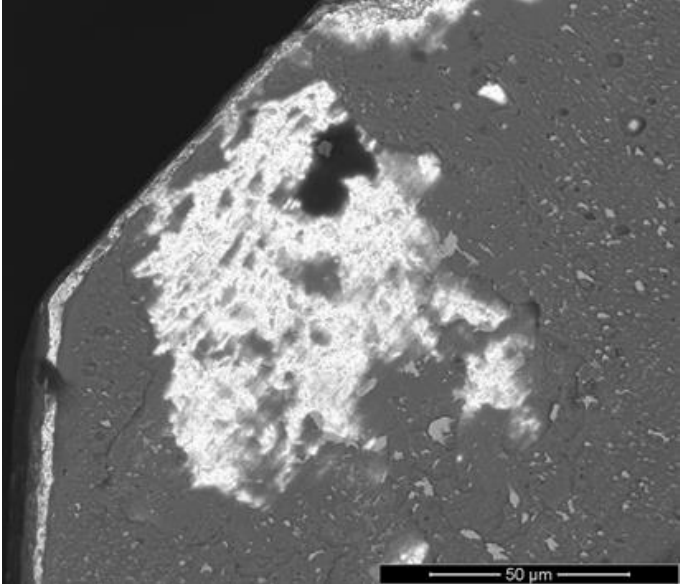
Figure 13. Rake face of a T2 tool tested at 4-m cutting length and 125% feed rate showing adhesive wear and coating delamination.